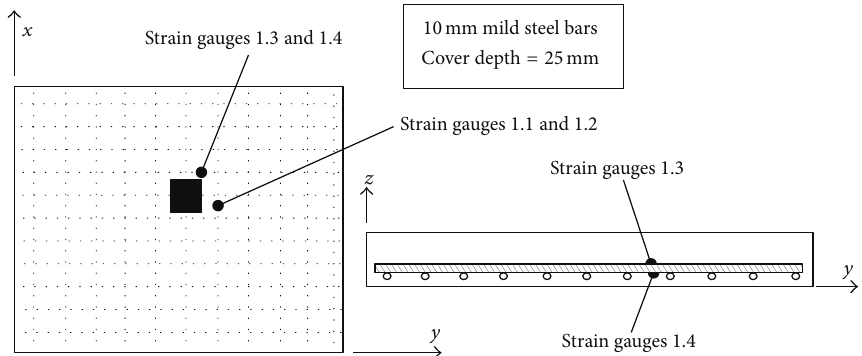
Figure 4: Reinforcement details and location of strain gauges 1.1 to 1.4 in slab S1.